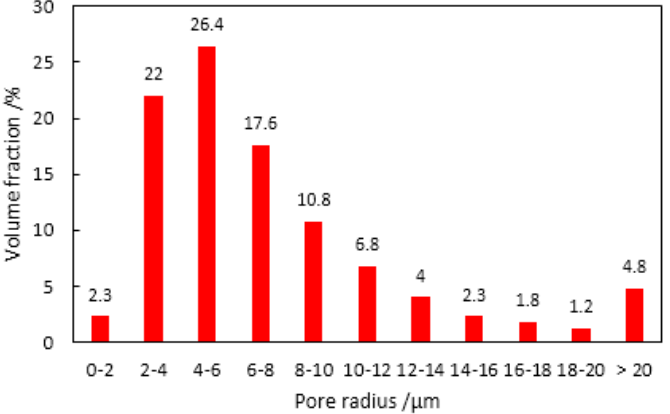
Figure 8. Variation of pore volumes at different pore radius for the tight rocks of Chang 7.